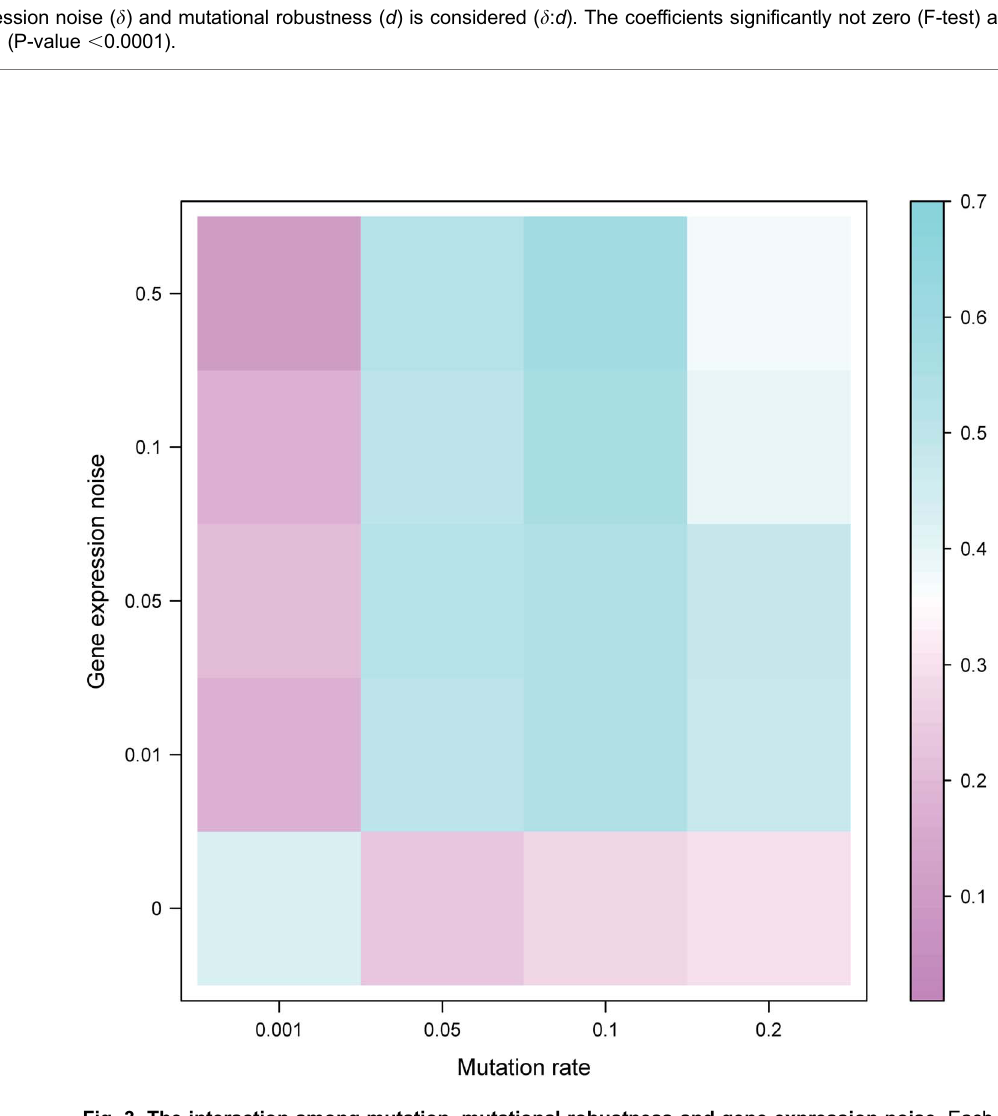
Fig. 3. The interaction among mutation, mutational robustness and gene expression noise. Each square represents a set of simulations with identical gene expression noise level and mutation rate. The color in each square index R was defined as the proportion of simulation pairs indicating that a population with higher mutational robustness would be more phenotypically heterogeneous than a population with lower mutational robustness after stabilizing selection. The population size is